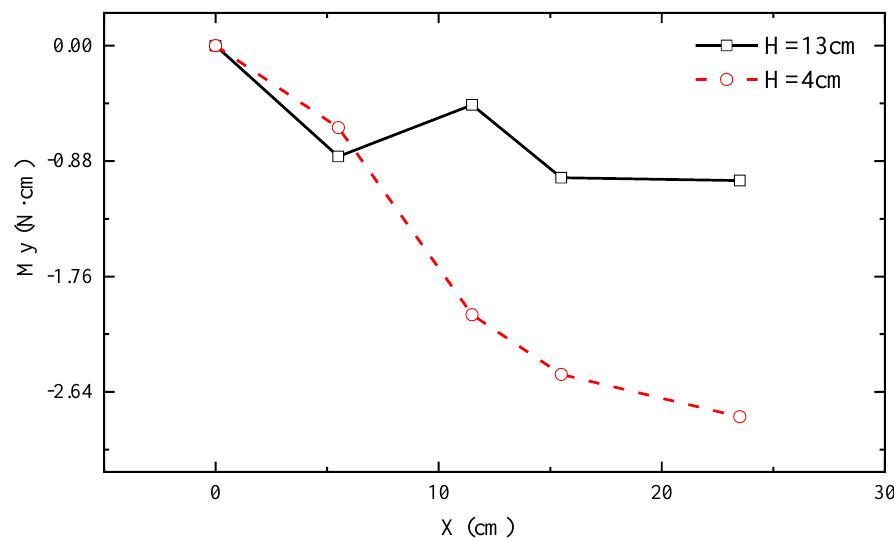
Figure 16. The lateral moment of child UAV in body-outside transition area. When the child UAV moves from the center of the parent UAV rotor to the outside, the effect of the downwash flow on lift decreases approximately linearly. The lift gradient increases as the relative height decreases as shown in Figure 17. Due to the suction effect by the nearby parent UAV rotor, the child UAV is subjected to a significant lateral moment, as shown in Figure 18, and this lateral moment will increase first and then decrease with distance. The asymmetric lateral moment reaches the maximum when the child UAV is located at the tip of the rotor of parent UAV, which may pose a threat to the flight safety. According to the interference extent in the transition aera, the influence extents are shown in Figure 19.